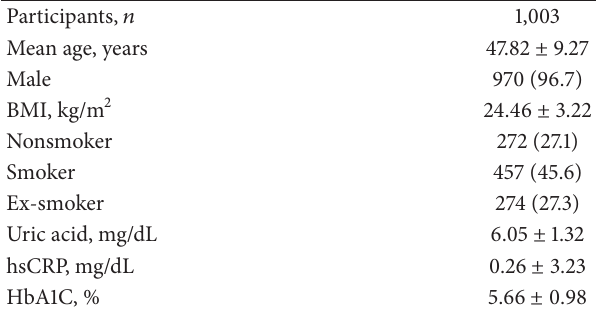
Table 1: Baseline characteristics of the participants.